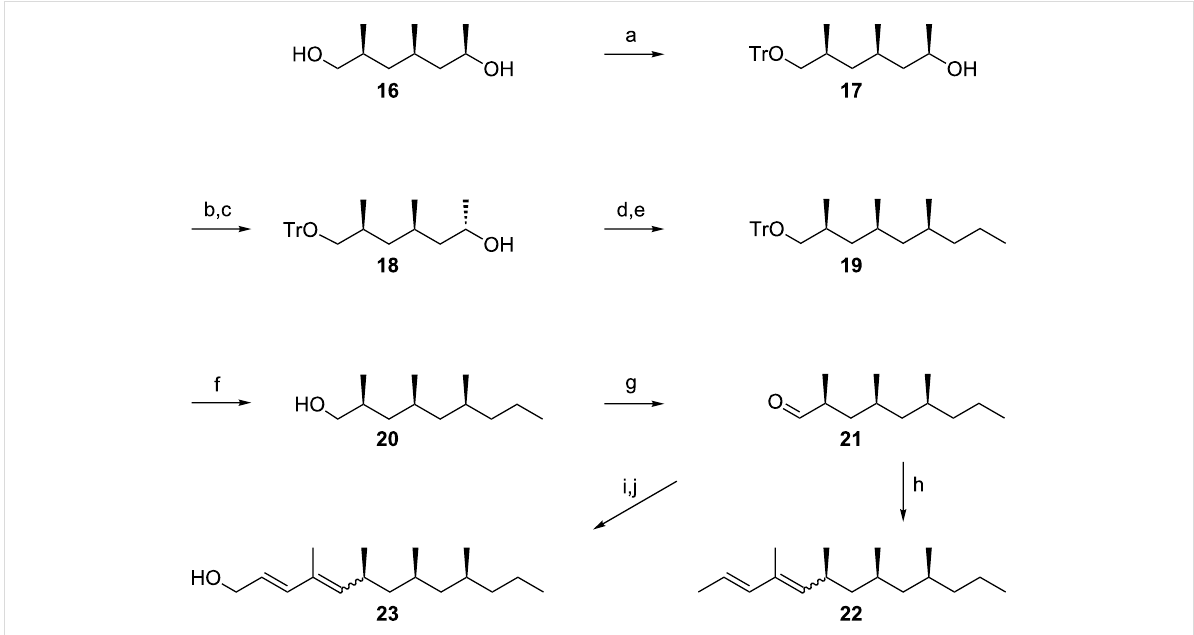
Figure 4: Synthesis of (2 E ,4 EZ )- syn , syn -4,6,8,10-tetramethyltrideca-2,4-diene ( 22 ), as well as (2 E ,4 E )- and (2 E ,4 Z )- syn , syn -4,6,8,10-tetramethyl- trideca-2,4-dien-1-ol ( 23 and 23a ). Conditions: a: TrCl, DMAP, TEA, DCM, rt, 16 h; b: 1) DIAD, TPP, THF, − 20 °C, 30 min; 2) 3,5-DNBA, rt, 40 min; 3) 17 , rt, 17 h; c: 2 N NaOH aq, THF/MeOH, rt, 45 min; d: MsCl, TEA, DCM, − 80 °C, 2 h; e: n -propylmagnesium bromide, CuI, THF, − 90 °C to rt, 48 h; f: p -TsOH, MeOH/THF/H 2 O, rt, 2 h; g: PDC, MS 4 Å, DCM, − 20 °C, 90 min; h: [( E )-1-methylbut-2-en-1-yl]triphenylphosphonium bromide, n -BuLi, LiBr, THF, − 40 °C, 12 h; i: 1) diethyl [(1/2 EZ )-3-(methoxycarbonyl)-1-methylprop-1/2-en-1-yl]phosphonate (as a mixture of isomers [23]), NaHMDS, LiBr, THF, − 90 °C, 1 h; 2) 21 , − 70 °C to rt, 16 h; j: DIBAlH, DCM, − 80 °C to rt, 2.5 h.